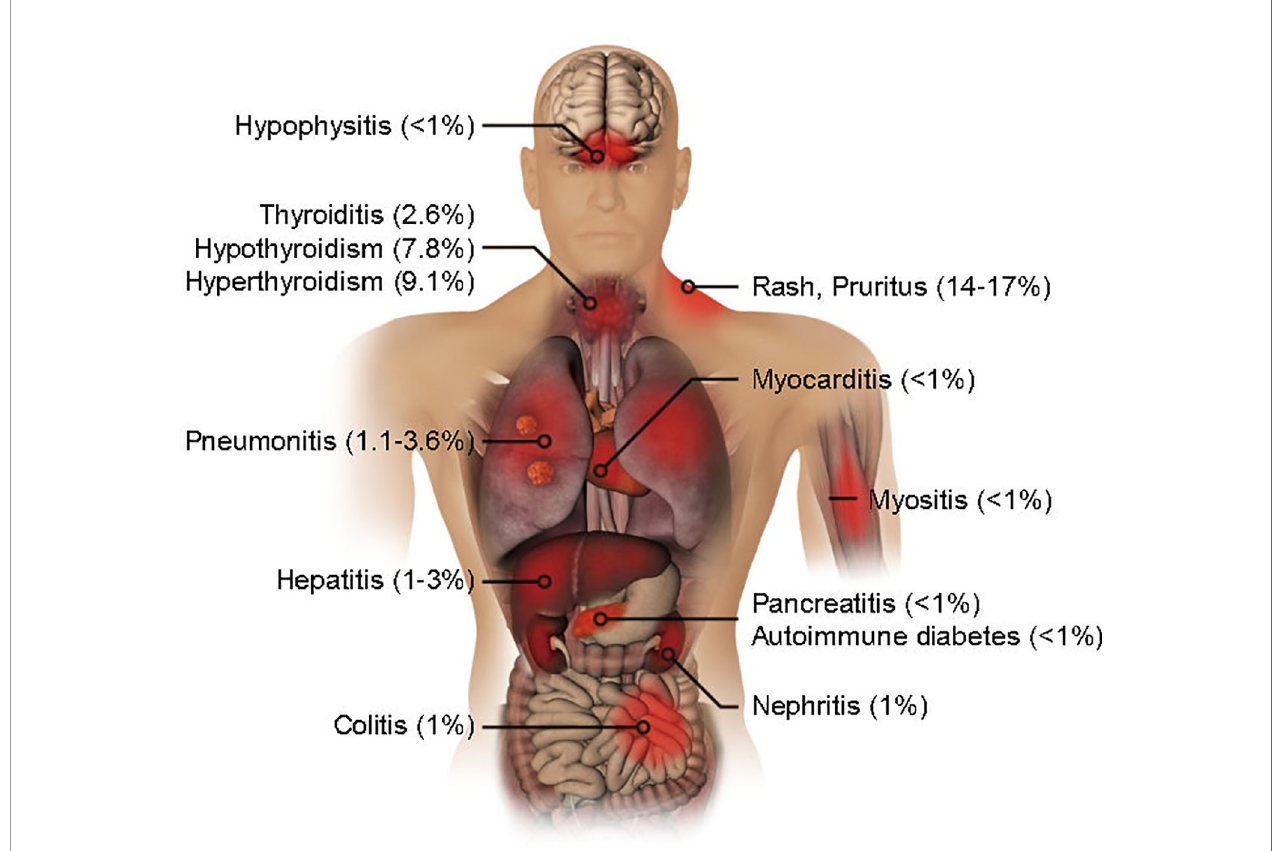
FIGURE 1 | Organ-speci fi c immune-related adverse events by PD-1 blockade in lung cancer treatment. The incidence rates are